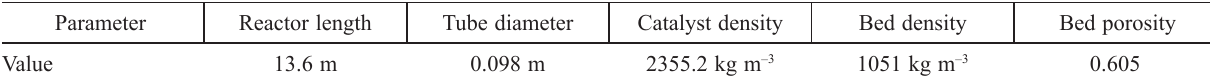
Table 3 – Model input